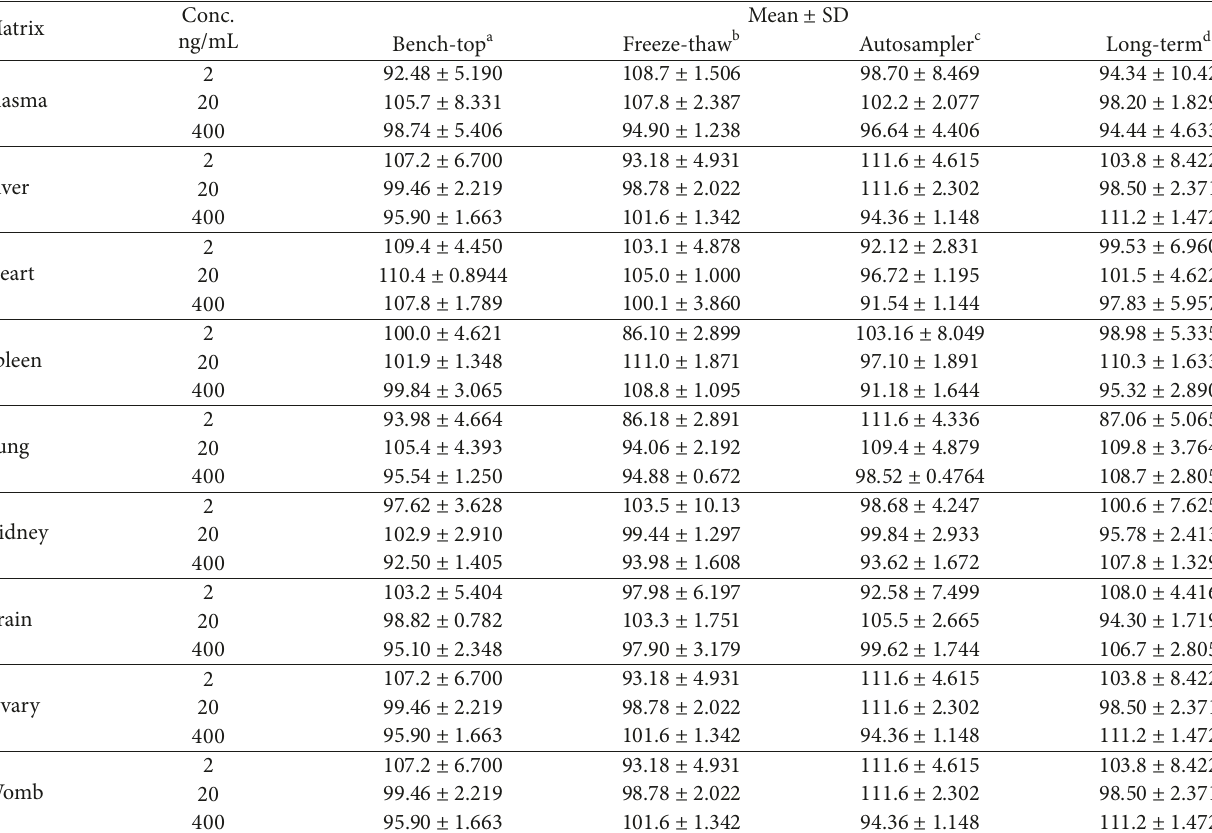
Table 4: Stability of epimedin B in plasma and tissue samples ( 𝑛 = 6 ).